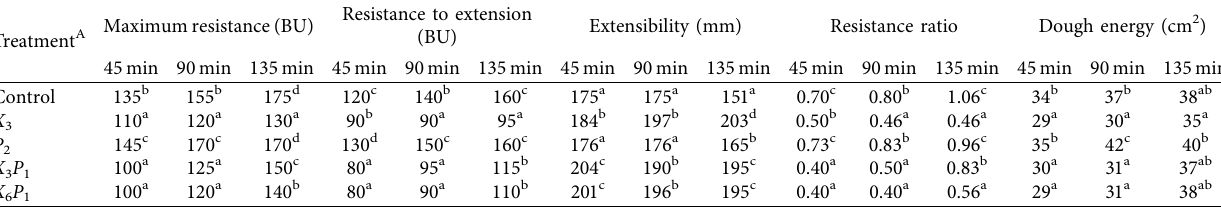
Table 3: Extensographic properties of the dough samples at 45, 90, and 135min resting time periods. Maximumresistance (BU) Treatment A